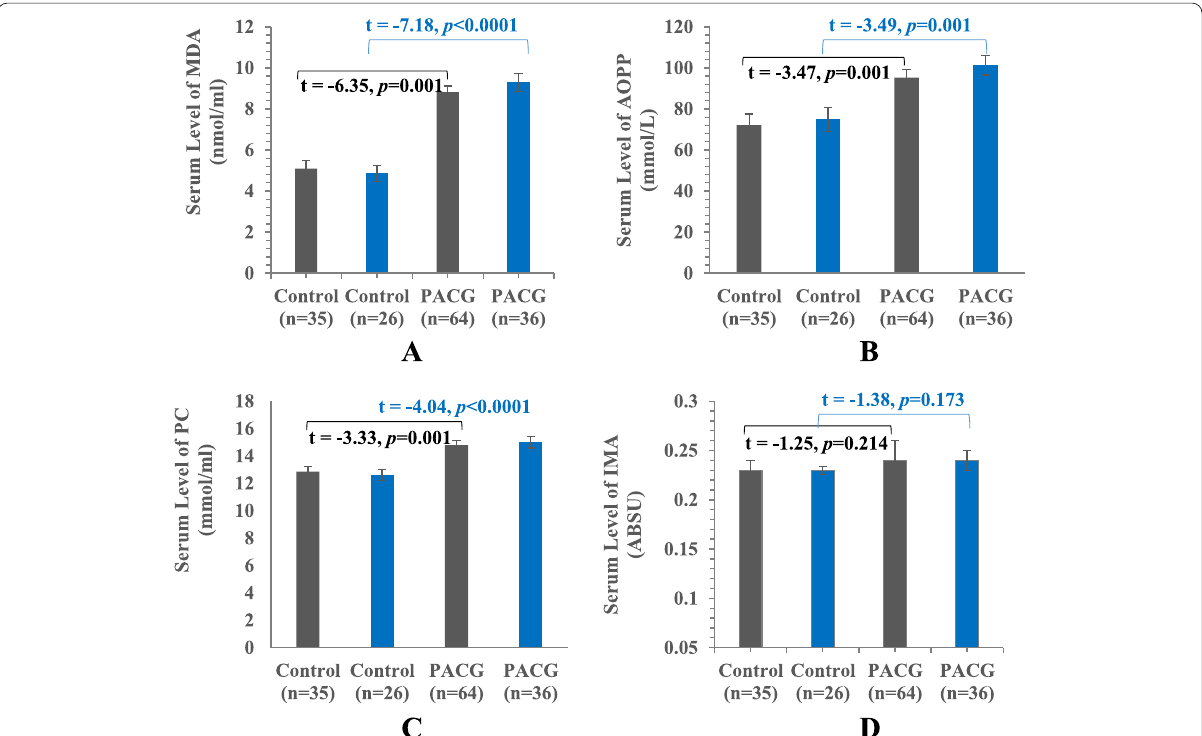
Fig. 1 Levels of systemic oxidative stress markers in serum of all control ( n DM, hypertension, CVD, and smoking ( n primary angle-closure glaucoma; MDA, malondialdehyde; AOPP, advanced oxidation protein products; PC, protein carbonyl; IMA, ischemia-modified albumin; ABSU, absorbance units. The mean difference is significant at p <0.05